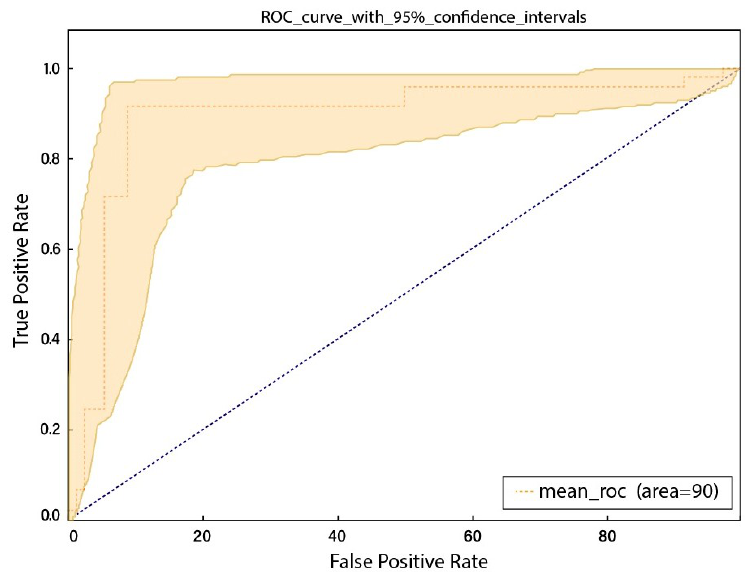
Figure 5. ROC curve with 95% confidence